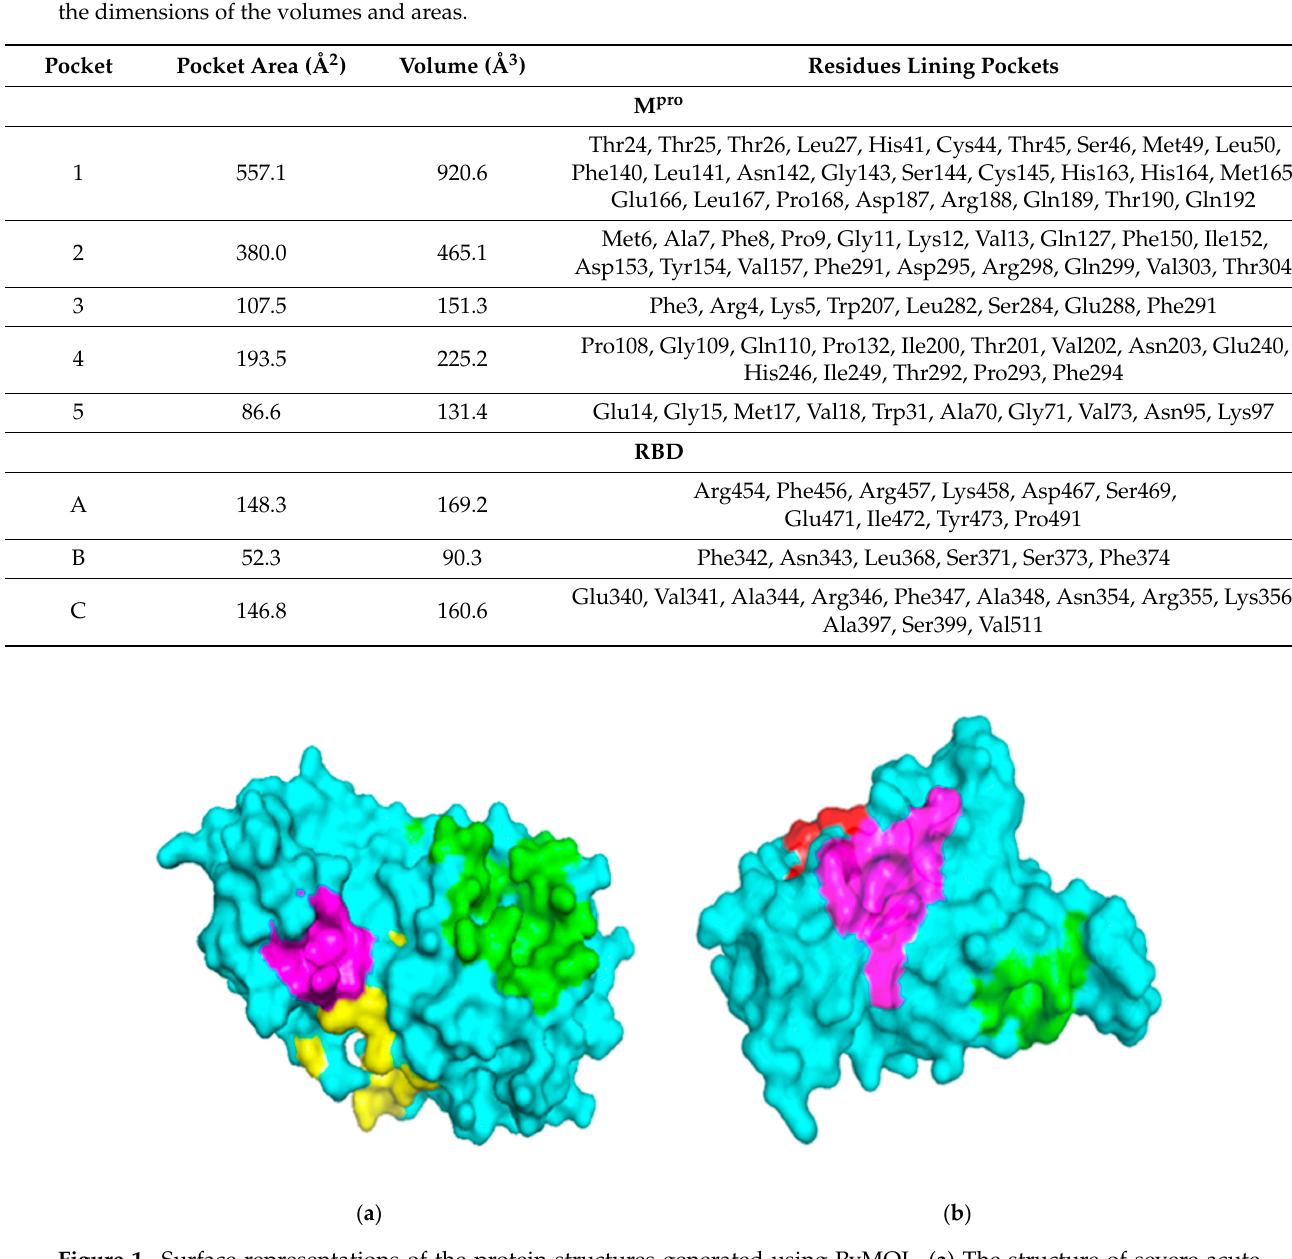
Figure 1. Surface representations of the protein structures generated using PyMOL. ( a ) The structure of severe acute respiratory syndrome virus 2 main protease (SARS-CoV-2 M pro ) is colored cyan, and the predicted binding pockets 1, 2, and 3 are colored green, yellow and magenta, respectively. ( b ) The receptor-binding domain (RBD) of the spike protein is colored cyan, and the predicted binding pockets A, B, and C are colored green, red and magenta, respectively. Ser1, His41, Met49, Gly143, Phe140, Ser144, Cys145, His163, His164, Glu166, Pro168 and Gln189 have been determined in previous studies as lining the active sites of M pro